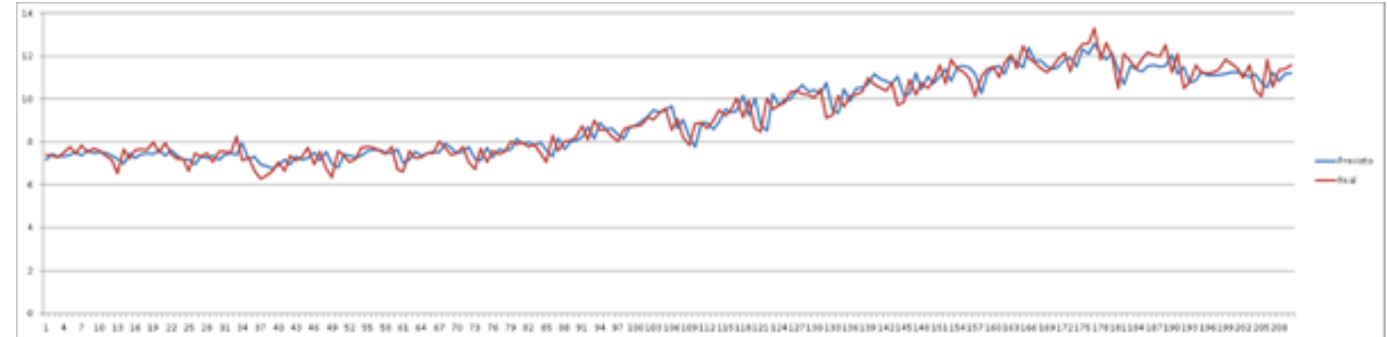
Figura 5: Gráfico comparativo entre os valores reais e os previstos pela rede neural. Fonte: Autores, (2017).